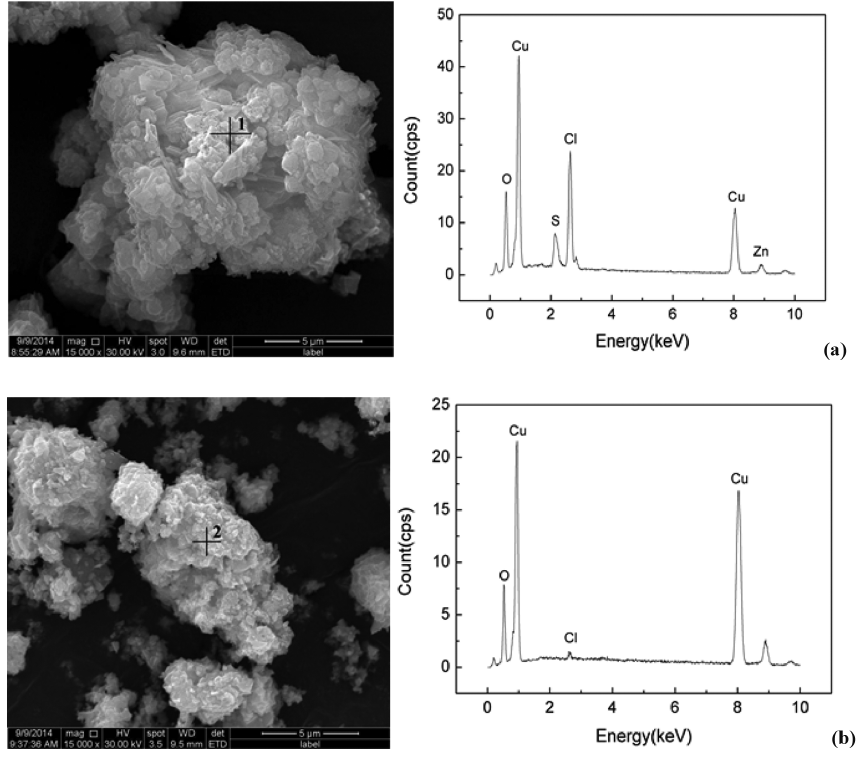
Figure 8 SEM and EDS analysis results of samples before and after microwave roasting: (a) raw materials and EDS result of spot “ 1 ” ; and (b) microwave roasting at 450°C for 90 min and EDS result of spot “ 2. ”